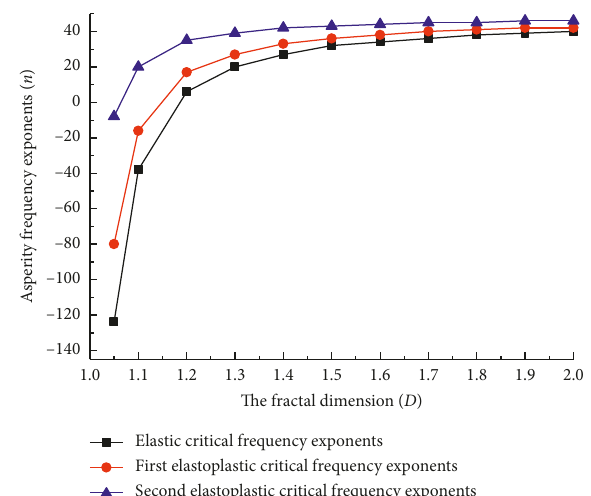
Figure 3: The relationship between fractal dimension D and critical frequency exponent n of a single